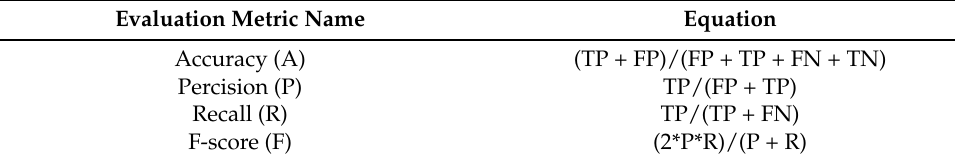
Table 5. Detailed equations for different performance evaluation